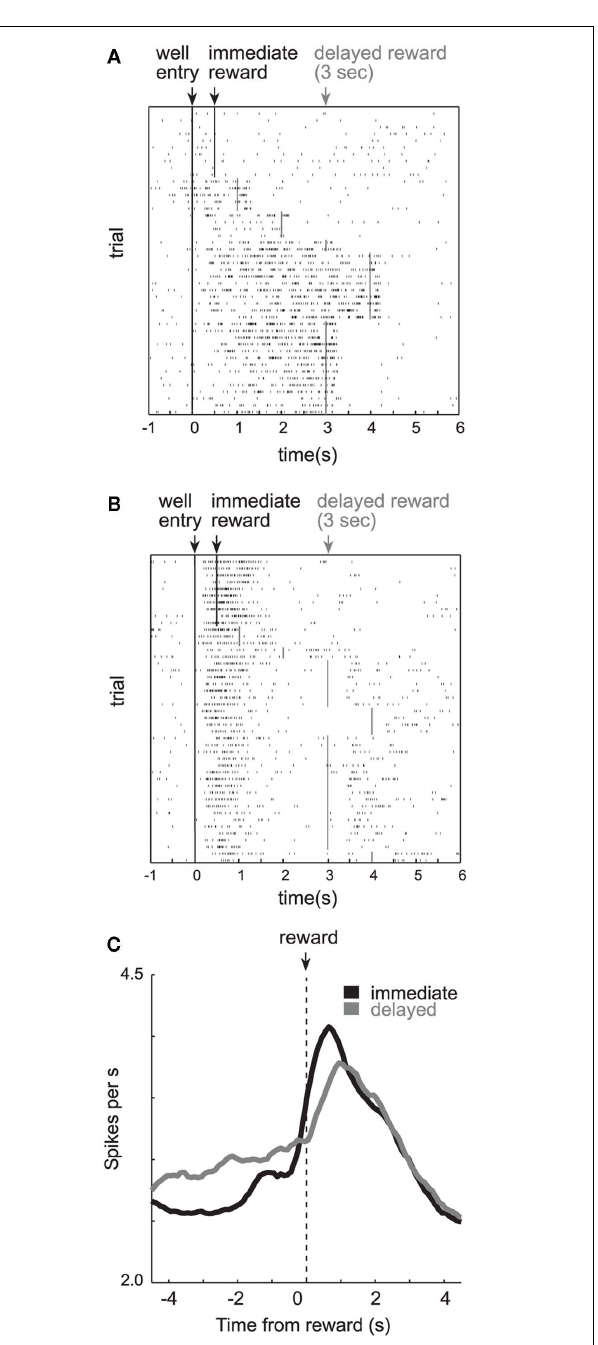
FIGURE 2 | Orbitofrontal cortex (OFC). (A) Single cell example of reward expectancy activity. (B) Single cell example of a neuron that exhibits reduced activity when rewards are delayed compared to when rewards are delivered immediately (black). Activity is plotted for the last 10 trials in a block in which reward was delivered in the cell’s preferred direction after 0.5s (black) followed by trials in which the reward was delayed by 1–4s (gray). Each row represents a single trial, each tick mark represents a single action potential and the colored lines indicate when reward was delivered. (C) Averaged firing rate of all OFC neurons that fired significantly ( p < 0.05) more strongly during a 1-s period after reward delivery compared to baseline (adapted from Roesch et al.,